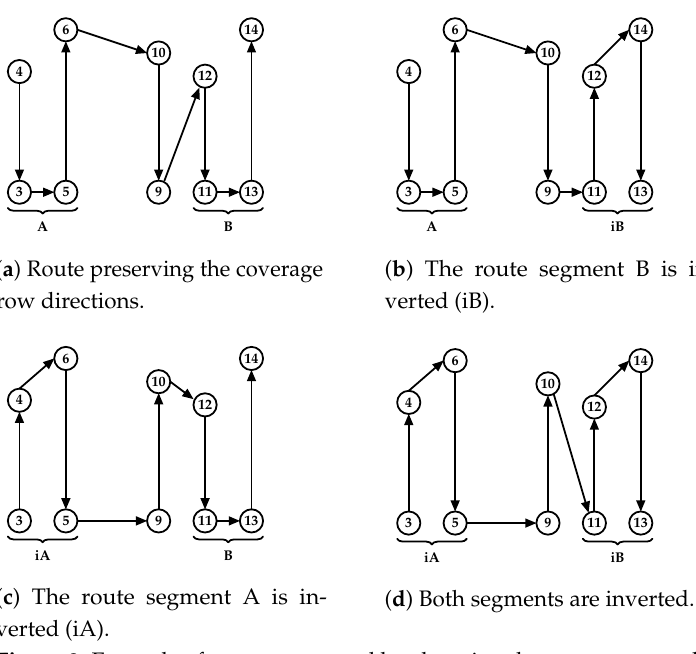
Figure 8. Example of routes generated by changing the coverage row